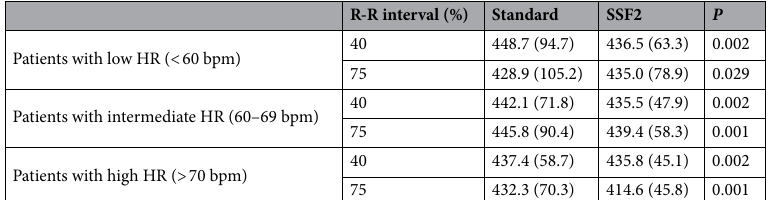
Table 4. Comparison of SD of the aortic annulus areas (mm 2 ) of scans subjected to standard- and SSF2 reconstruction. HR Heart rate, bpm Beats per minute. Values are the mean (SD).